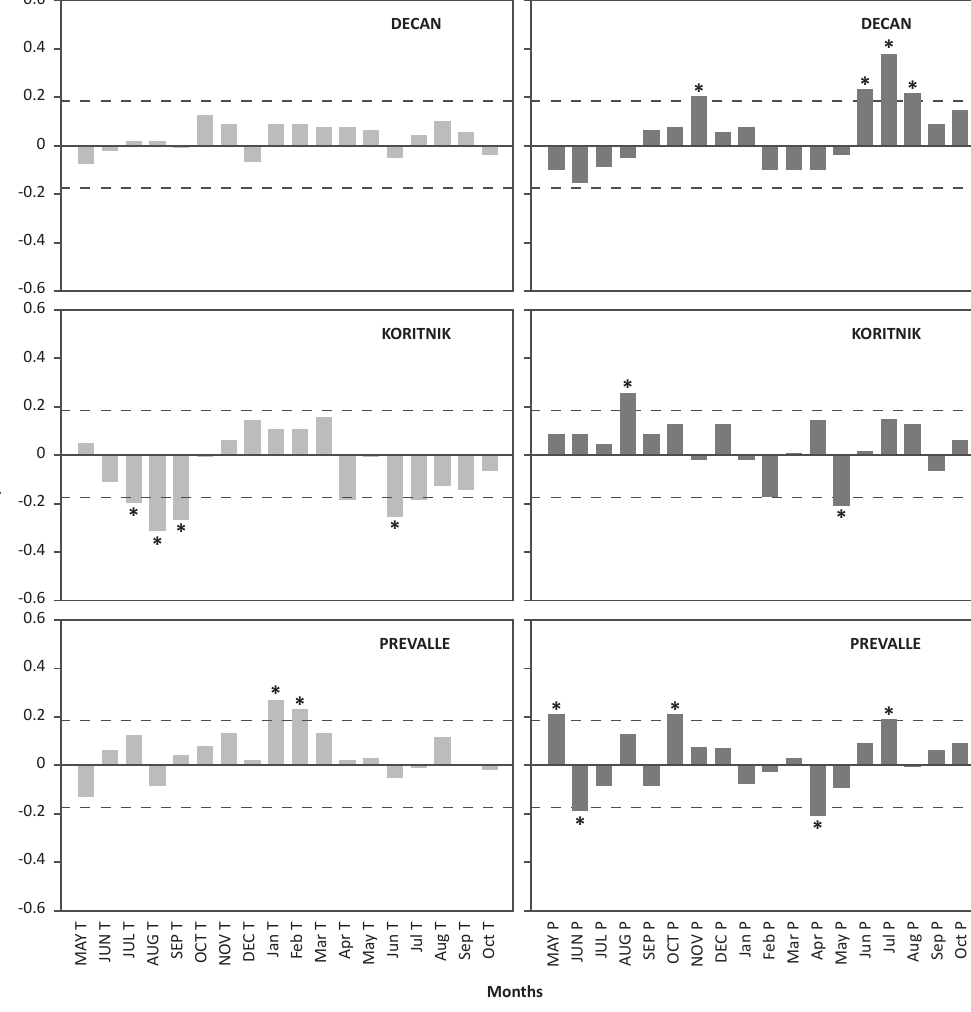
figURe 4. Bootstrap correlation coefficients between residual chronologies and temperature (left) and precipitation (right) - asterisks on the top of the bars indicate 95% significance level of the correlation